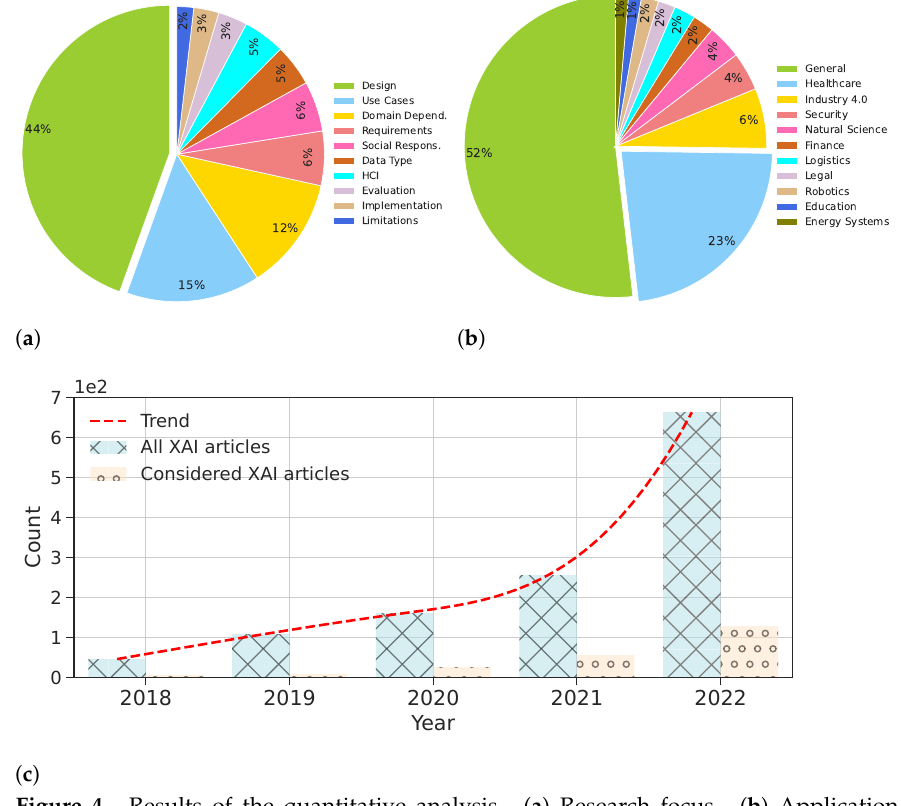
Figure 4. Results of the quantitative analysis. ( a ) Research focus. ( b ) Application domains. ( c ) Time